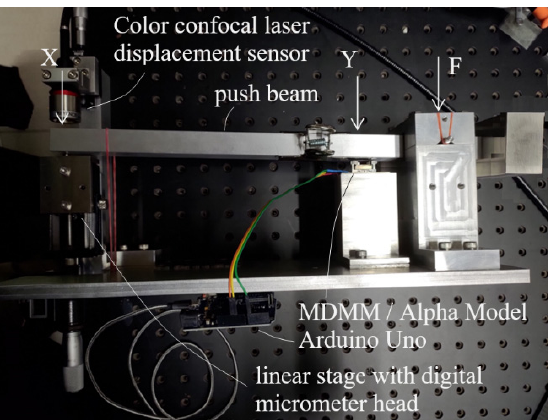
Figure 33. A second setup for testing/calibrating the LCMDS prototypes at different orientations, the picture showing the setup operating in horizontal orientation.